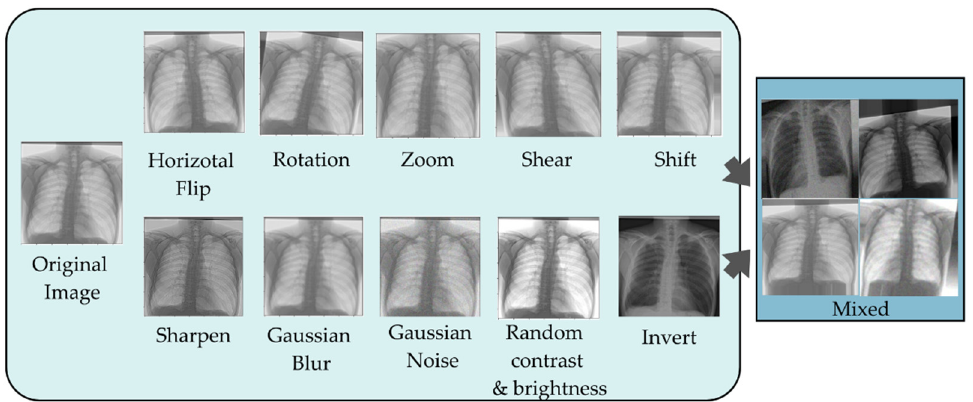
Figure 3. Image augmentation example.